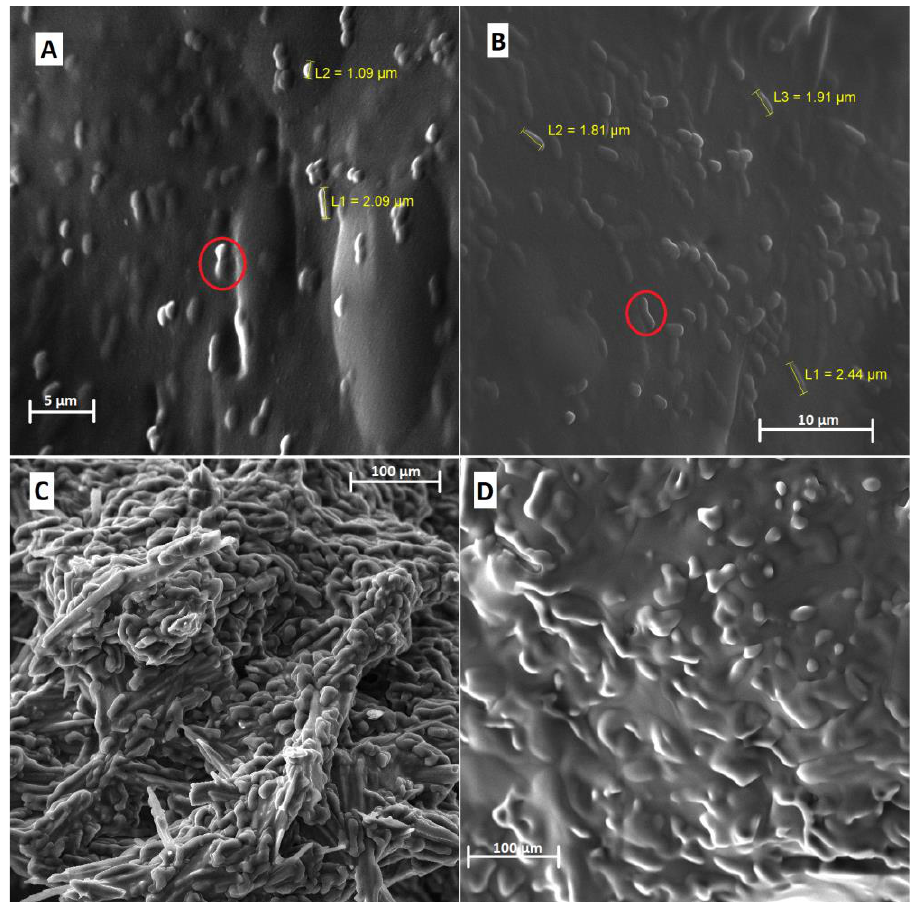
Figure 1. Scanning electron microscopy of the formulations obtained by O/W emulsification. ( A ) LAEG- L. acidophilus in gelatin with a magnitude of 7.01 kx; ( B ) LPEG- L. plantarum in gelatin with a magnitude of 6.35 kx; ( C ) LAEA- L. acidophilus in alginate with a magnitude of 542×; ( D ) LPEA- L. plantarum in alginate with a magnitude of 565×. Red circles indicate the presence of microbial cells.